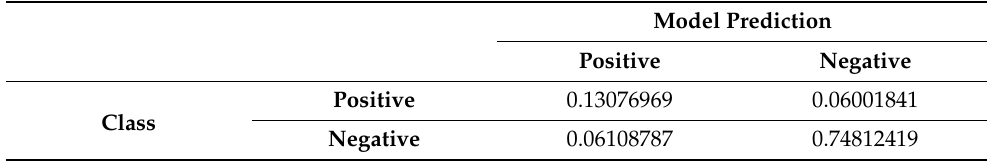
Table 7. Confusion matrix (Conventional U-Net/ large number of